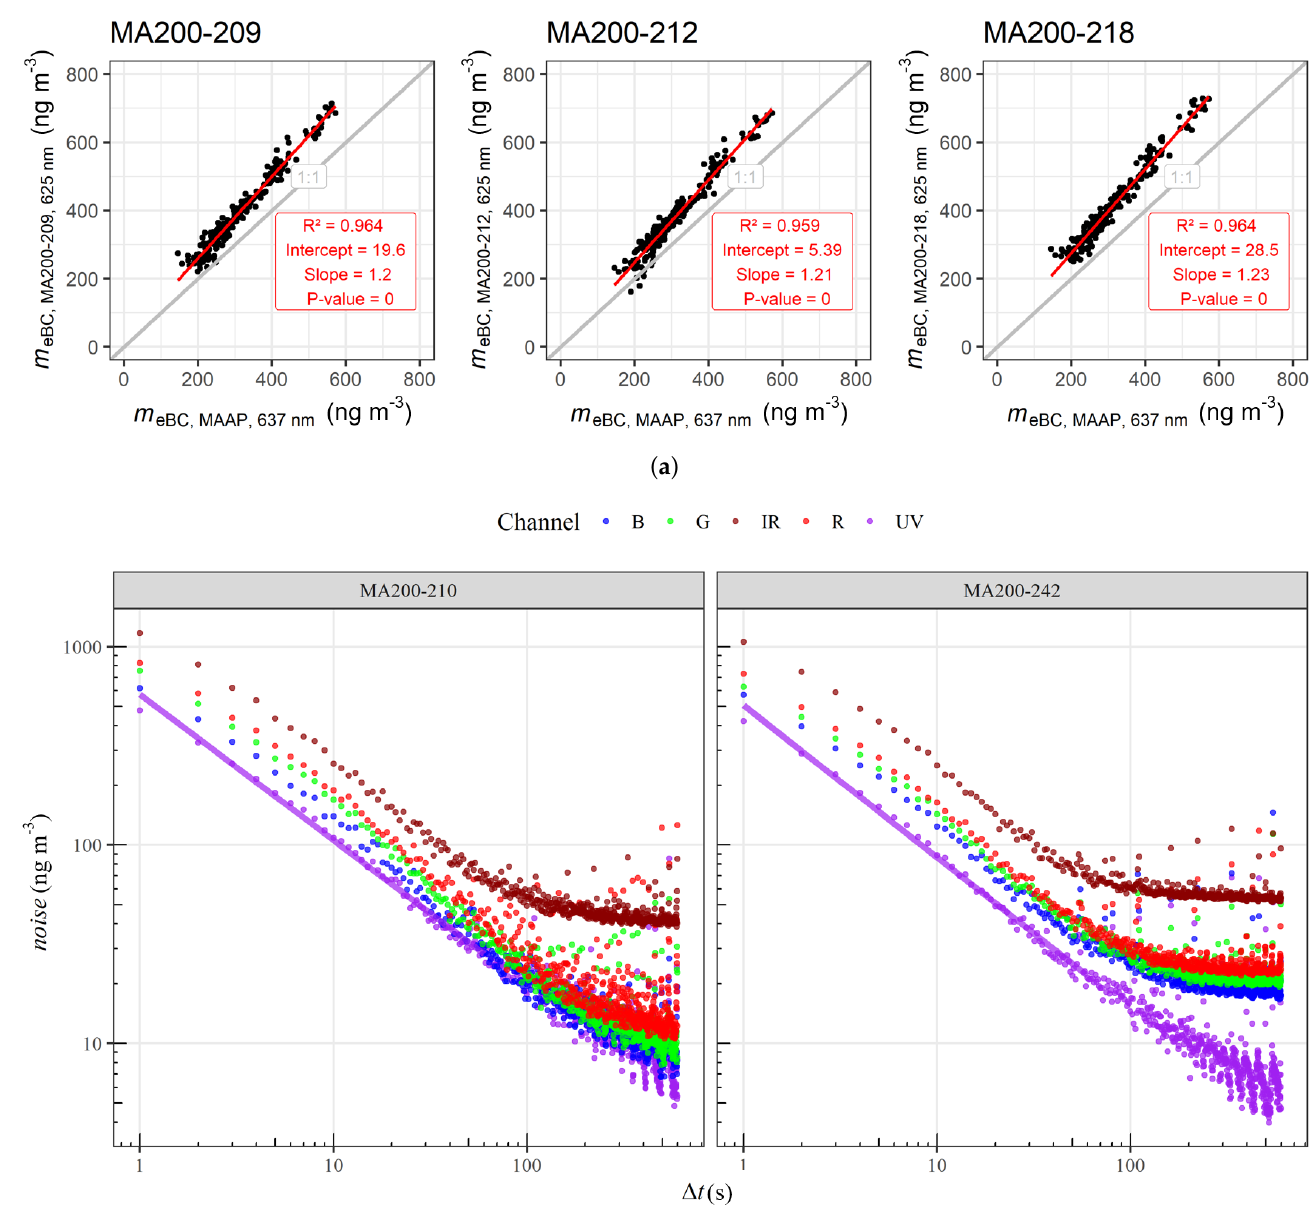
Figure 1. ( a ) Ambient air comparison of m eBC measured with 3 MA200 (Serial No. 209, 212, 218) with the 625 nm channel and the MAAP at 637 nm derived with a default mass absorption cross-section (MAC) of 6.6 m 2 g. ( b ) Noise in units of (ng m − 3 ) for the 5 channels (375 (UV), 470 (B), 528 (G), 625 (R) and 880 nm (IR) of the MA200 derived for 2 MA200 (Serial No. 210 and No. 242) for different averaging periods ( ∆ t ) in units of